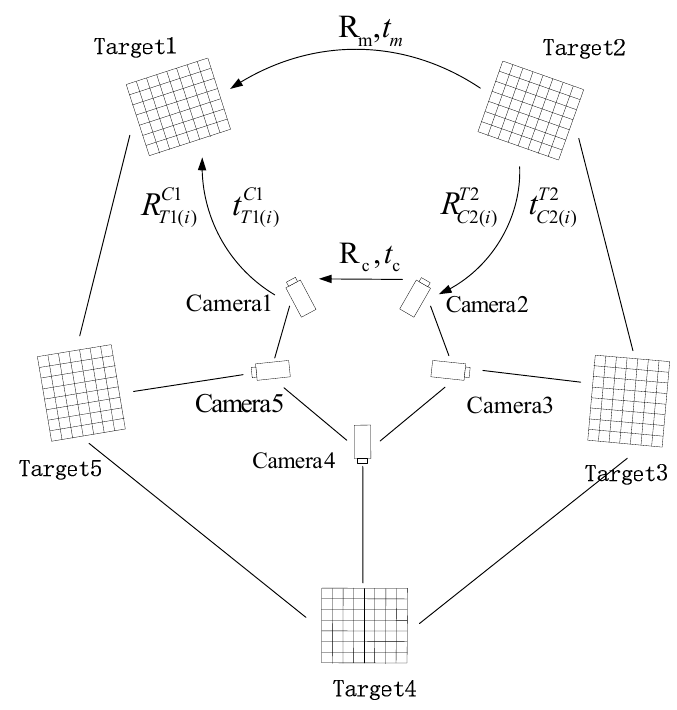
Figure 1. Extrinsic parameters calibration schematic.